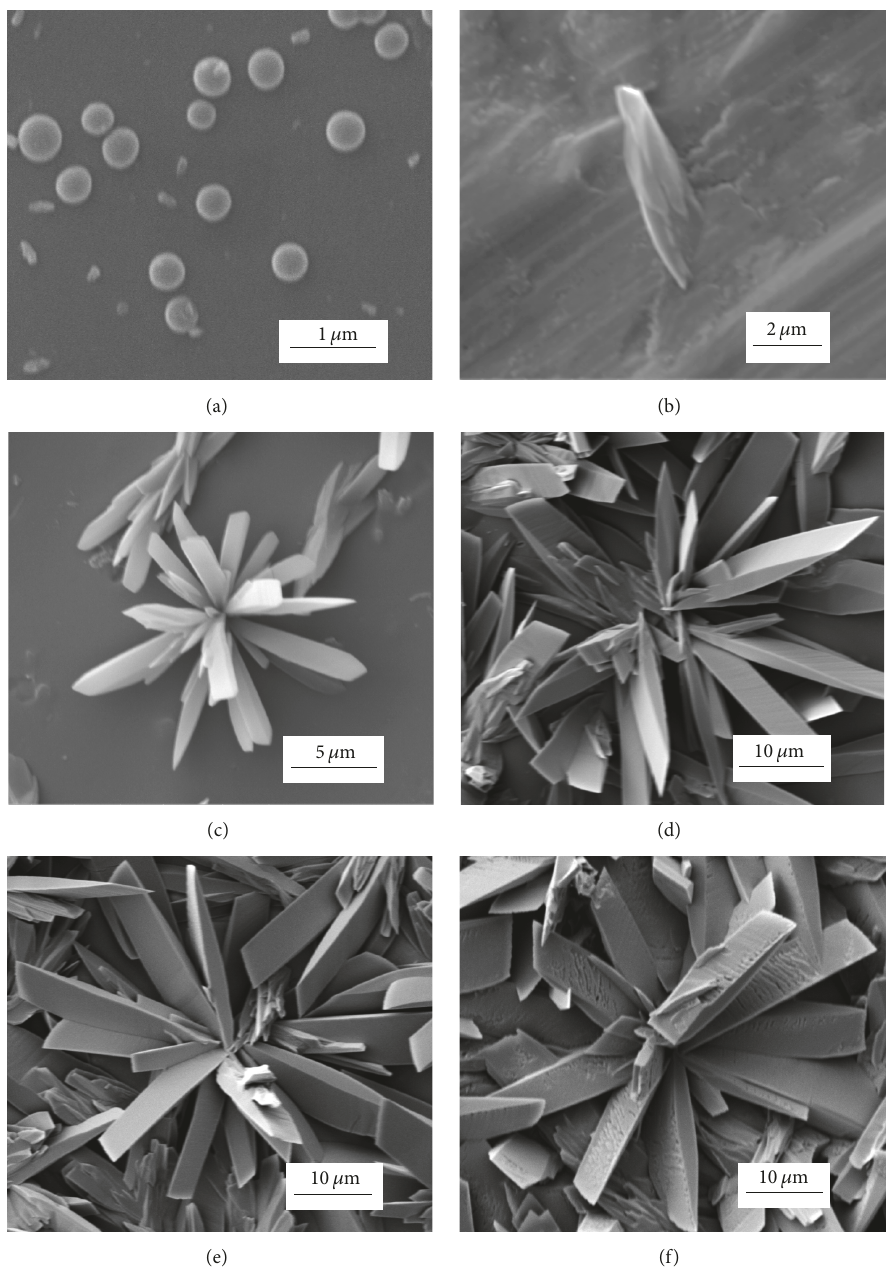
Figure 7: SEM images of Alq 3 growth on the one-step APA samples, observed after different dipping times: dipping alone (a) and (b); 10s (c); 60 s (d); 180 s (e); and 300 s (f). Images (a) and (b) were observed at different locations on the same